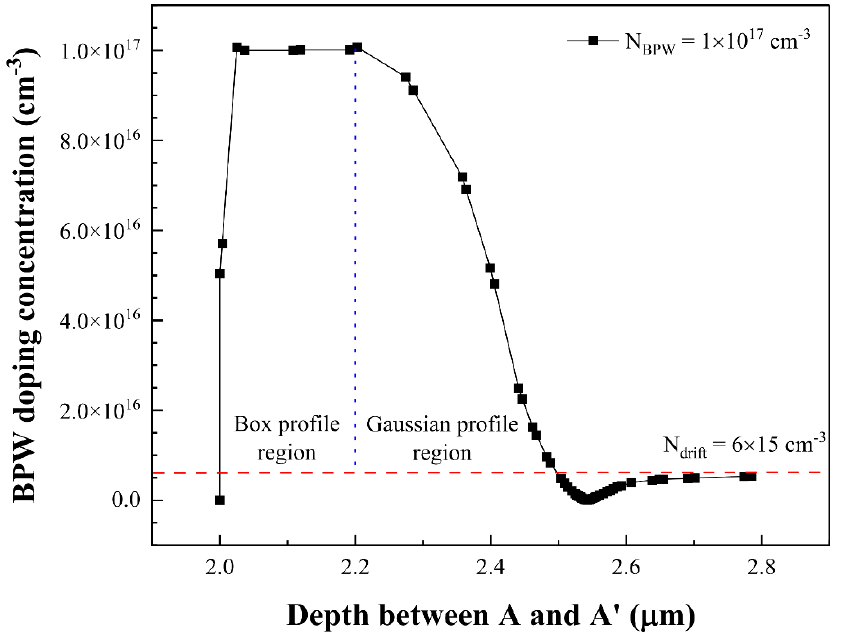
Figure 2. Depth profile of bottom protection p-well (BPW) doping concentration with N BPW of 10 17 cm -3 including box profile and Gaussian profile in the cutline A-A’ section line of the device.